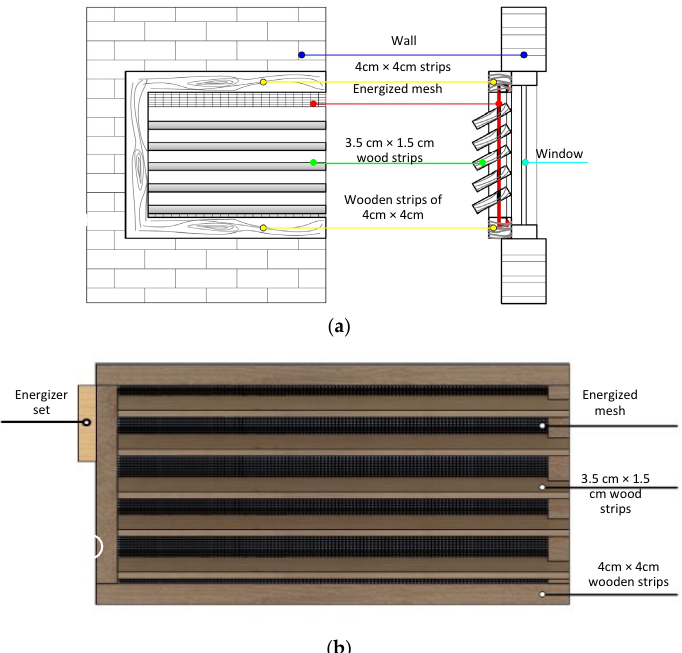
Figure 8. ( a ) Detail of lattice prototype, ( b ) modeling.